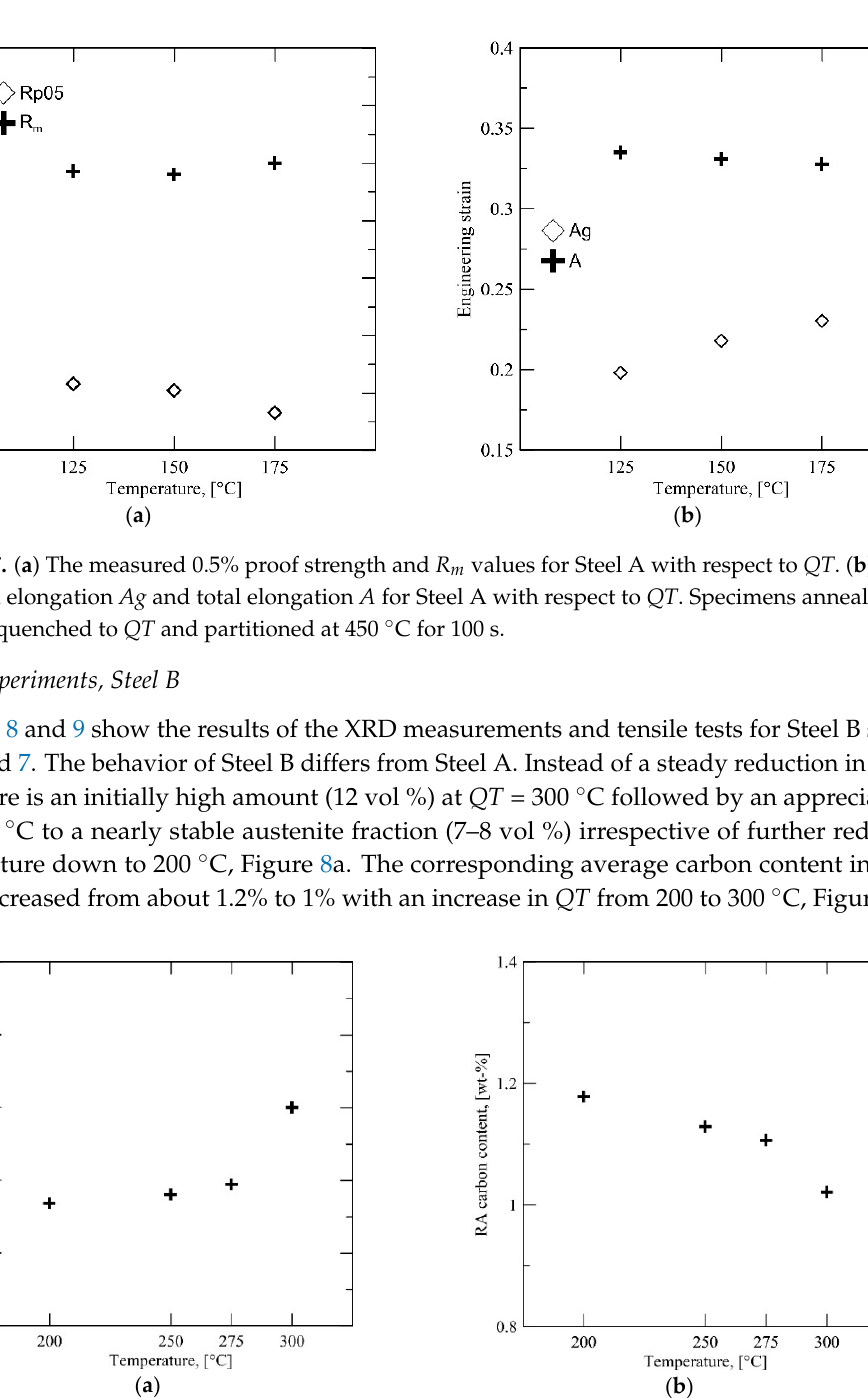
Figure 8. ( a ) The retained austenite fraction of Steel B with respect to initial quench temperature QT . ( b ) The carbon content of the retained austenite with respect to QT . Specimens annealed at 850 °C, quenched to QT and partitioned at 450 °C for 100 s.